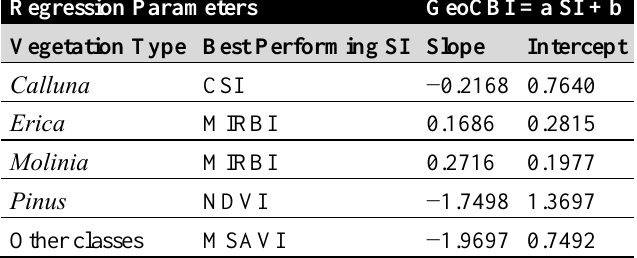
Table 7. Best performing spectral index and corresponding regression parameters, as used in the burn severity spatial distribution (Figure 5).